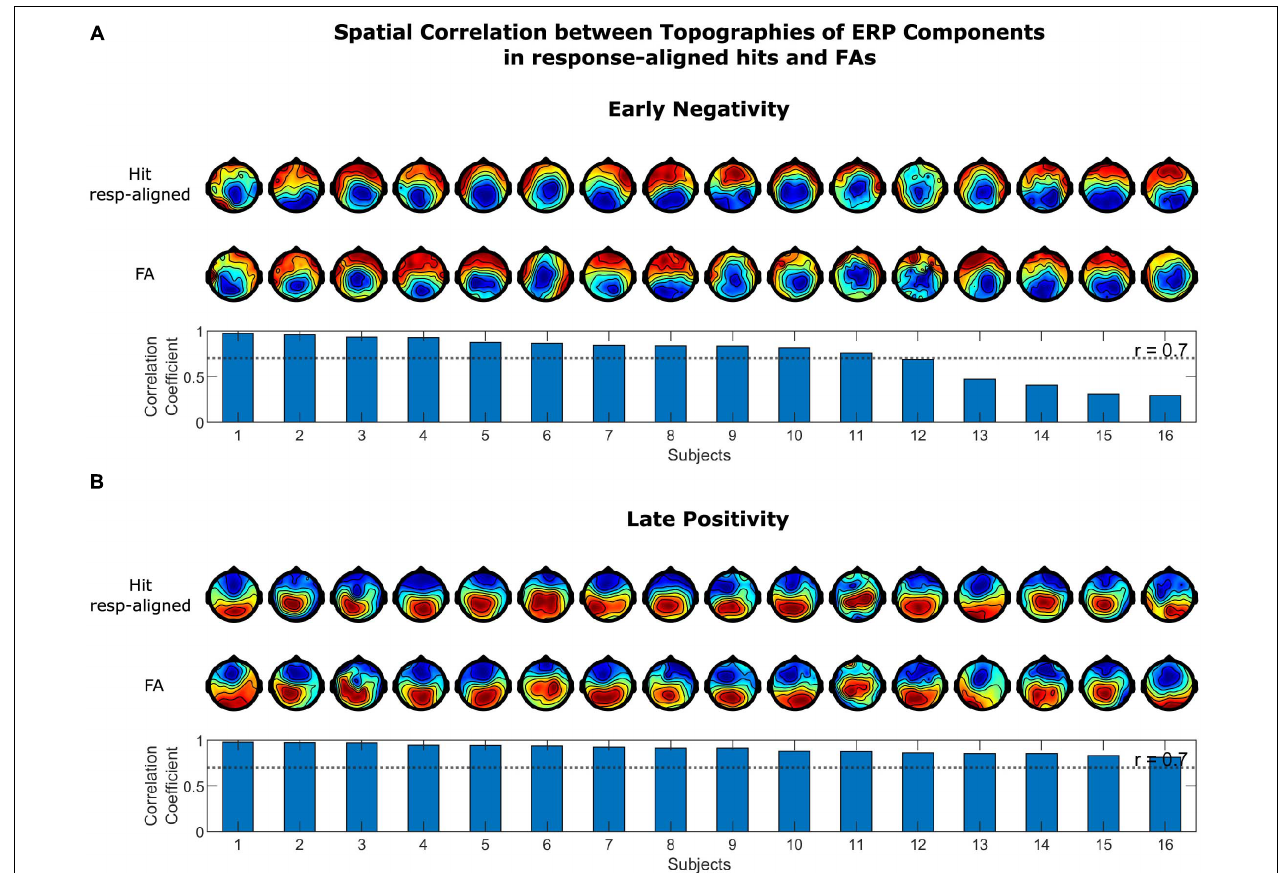
FIGURE 6 | Spatial correlation between topographies of ERP Components in response-aligned hits and FAs for (A) the early negativity and (B) the late positivity. Topographies in the upper row correspond to response-aligned hits and in the lower row to FAs. Scalp topographies of the components were highly correlated in response-aligned hits and FAs across most of the